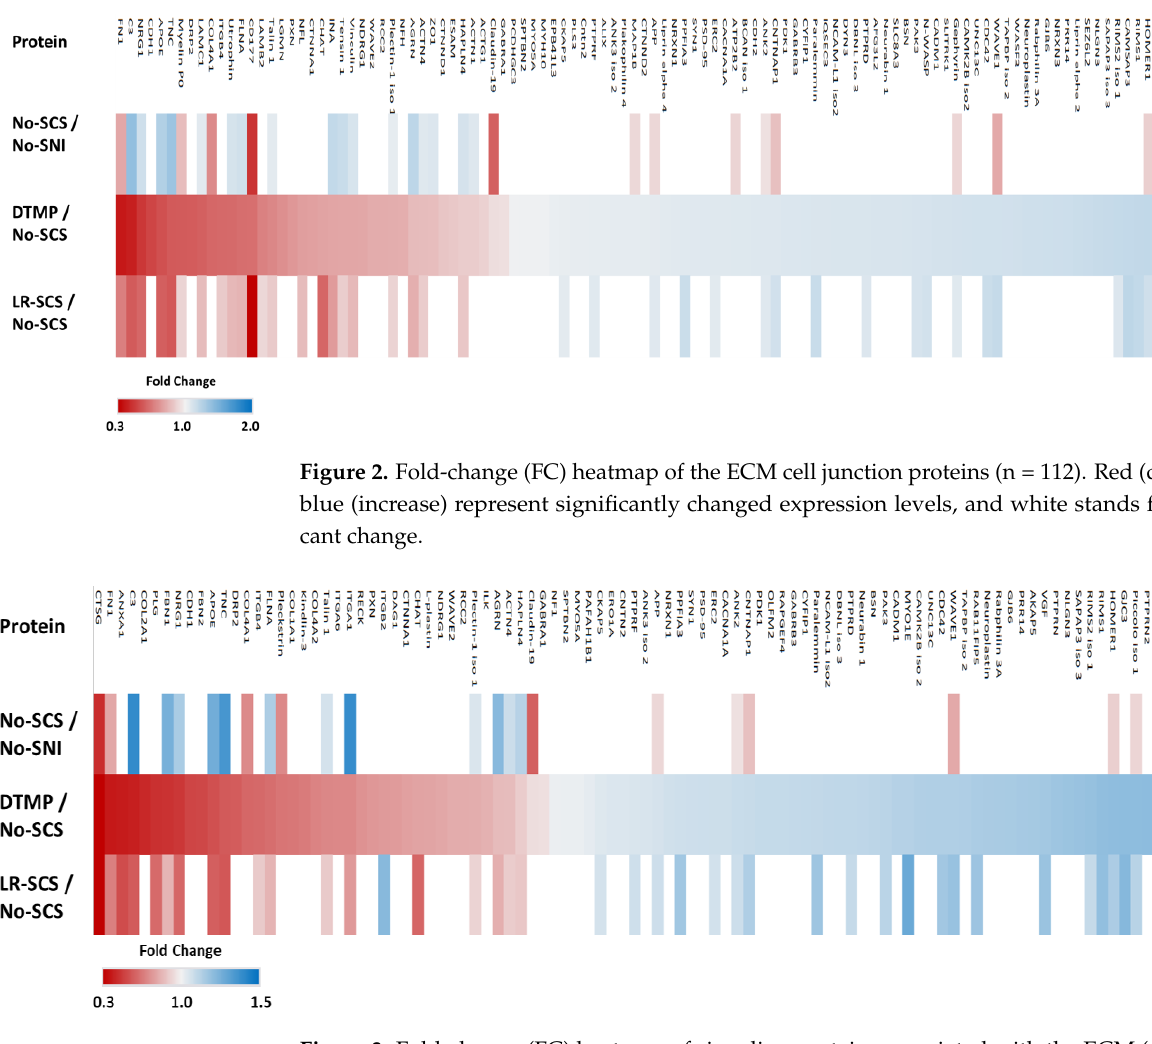
Figure 3. Fold-change (FC) heatmap of signaling proteins associated with the ECM (n = 102). Red (decrease) and blue (increase) represent significantly changed expression levels, and white stands for no significant change.